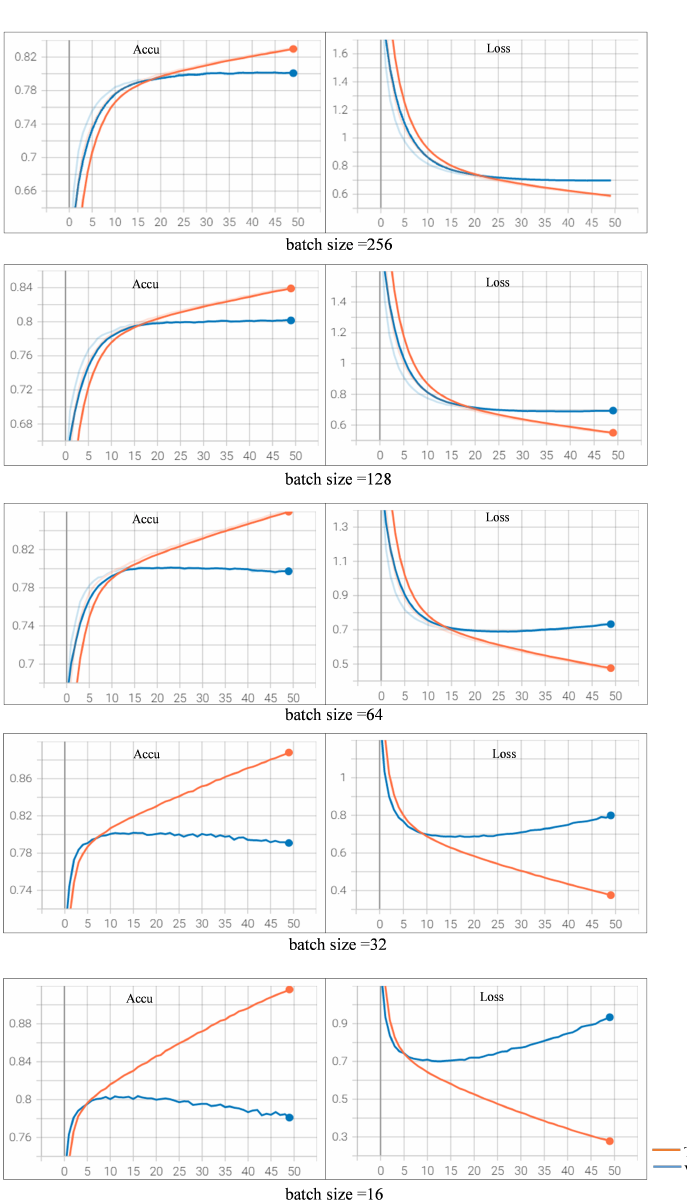
Figure A3. Performance of the improved transformers-based models. The models use the Adam optimizer and a learning rate of 1 × 10 − 6 over 50 epochs, varying different batch sizes. The other hyperparameters are set the same as the model built in the preliminary